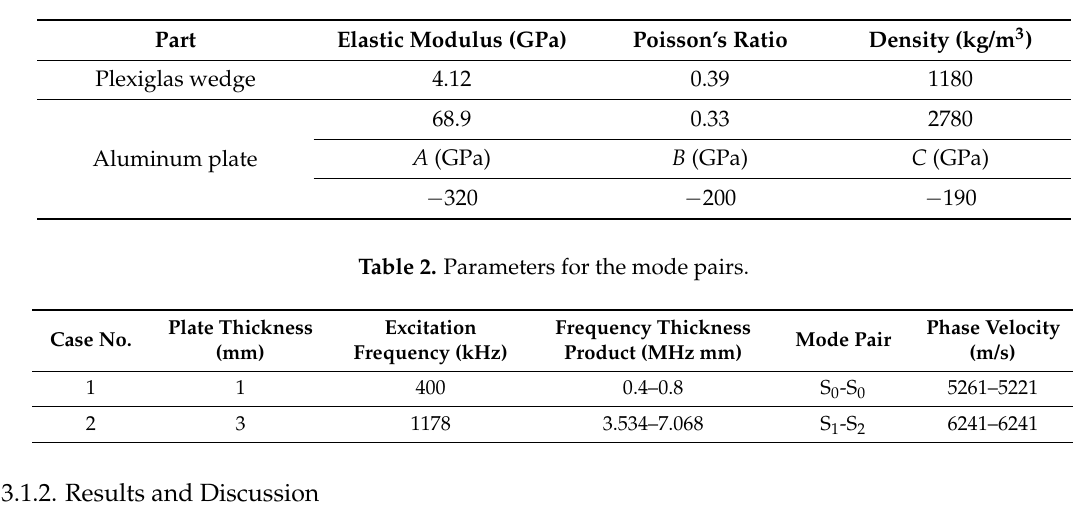
( a ) ( b ) Figure 3. Phase velocities for the mode pair ( a ) S 0 -S 0 0.4–0.8 MHz mm and ( b ) S 1 -S 2 at 3.534–7.068 MHz mm. Table 1. Material parameters for the plate structure.